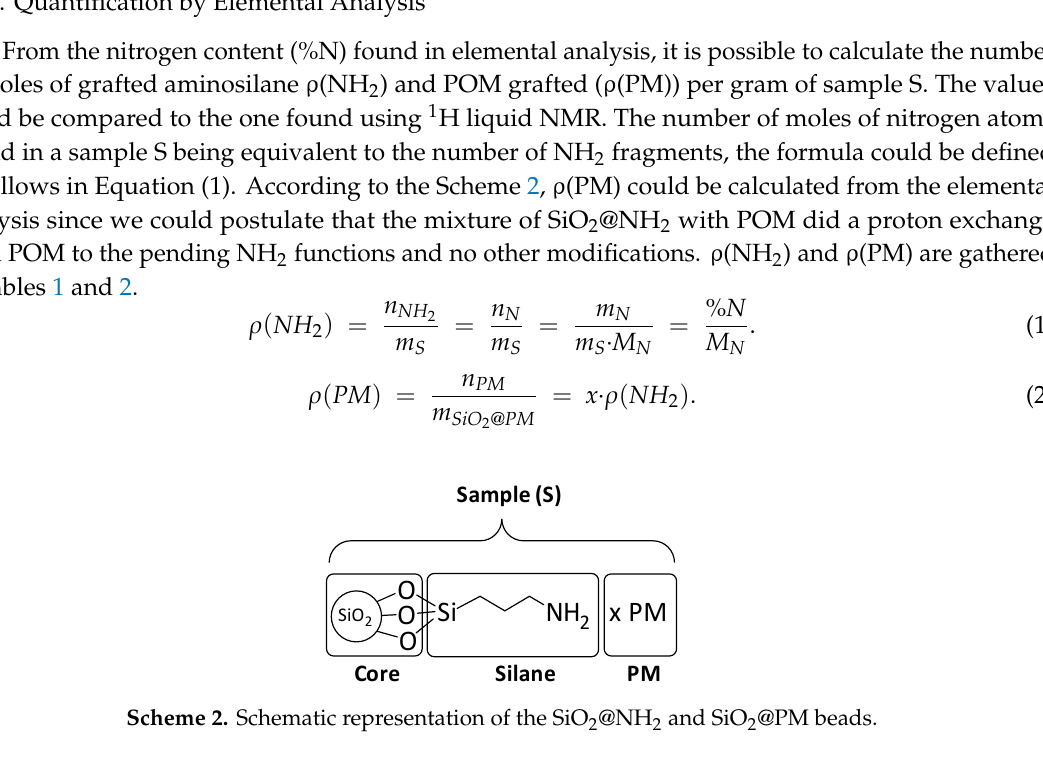
Figure 5. 29 Si CP MAS NMR spectra of SiO 2 ( a ), SiO 2 @NH 2 ( b ), SiO 2 @PW ( c ) and SiO 2 @PMo ( d